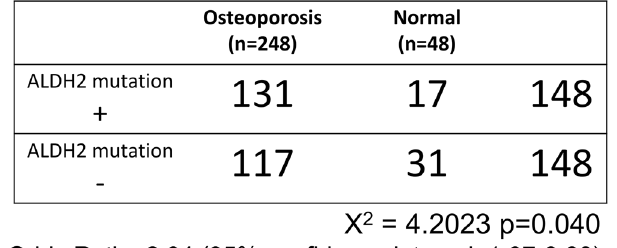
Figure 3. ALDH2 rs671 mutation in osteoporosis and normal groups. The presence of rs671 in research subjects was analyzed by direct sequencing. Subjects heterozygous or homozygous for the mutation are designated ( + ) and subjects with the wild-type ALDH2 gene are designated ( − ). Odds ratios and 95% confidence intervals for rs671 in the hip fracture group were determined, and a Chi-square test was performed.